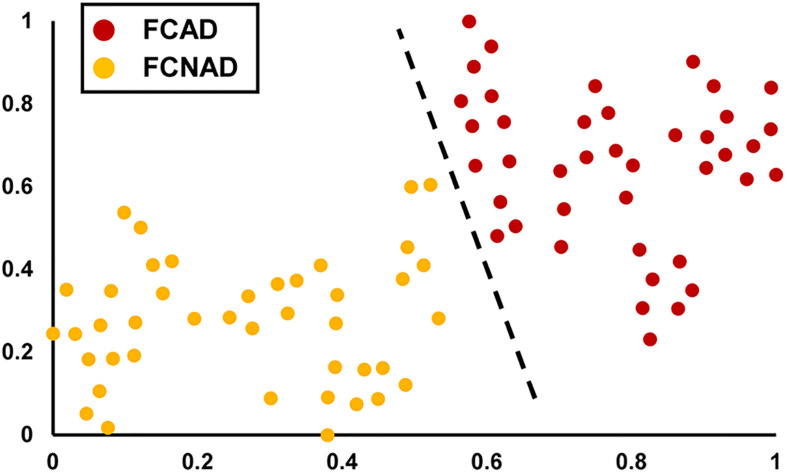
The unsupervised machine learning clustering algorithm identified a two-cluster solution (shown by t-SNE). The red points represent FCAD patients, and the orange points represent FCNAD patients. t-SNE, t-distributed stochastic neighbor embedding; FCAD, functional constipation associated with anxiety/depressive status; FCNAD, functional constipation without anxiety/depressive status.